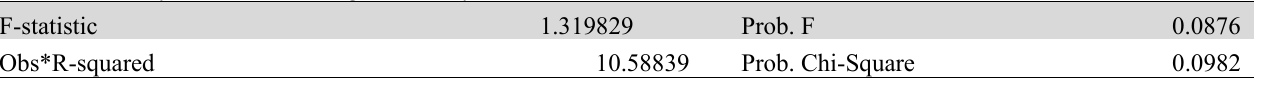
Heteroskedasticity Test: Breusch-Pagan-Godfrey